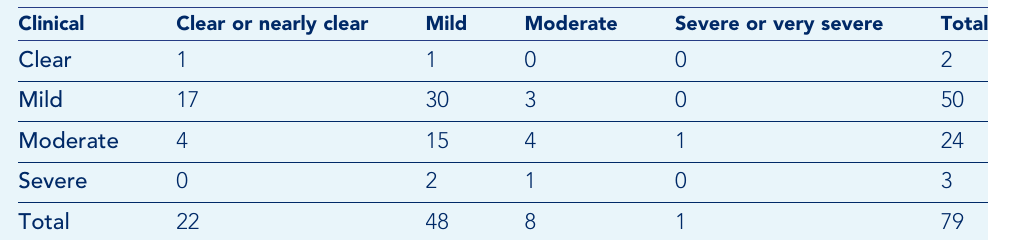
Table S2. Clinical and EASI assessments of eczema severity